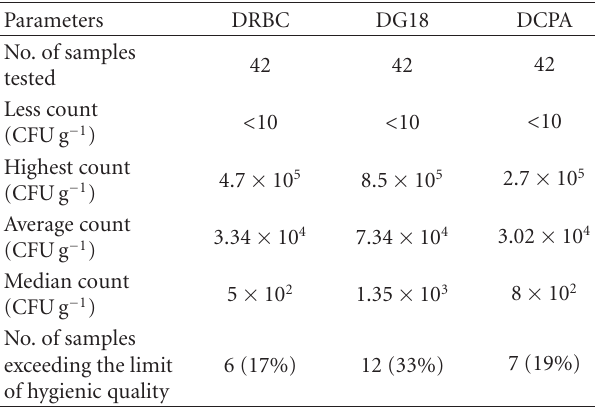
Table 1: Fungal counts (CFUg − 1 ) from chinchilla and rabbit feed samples.